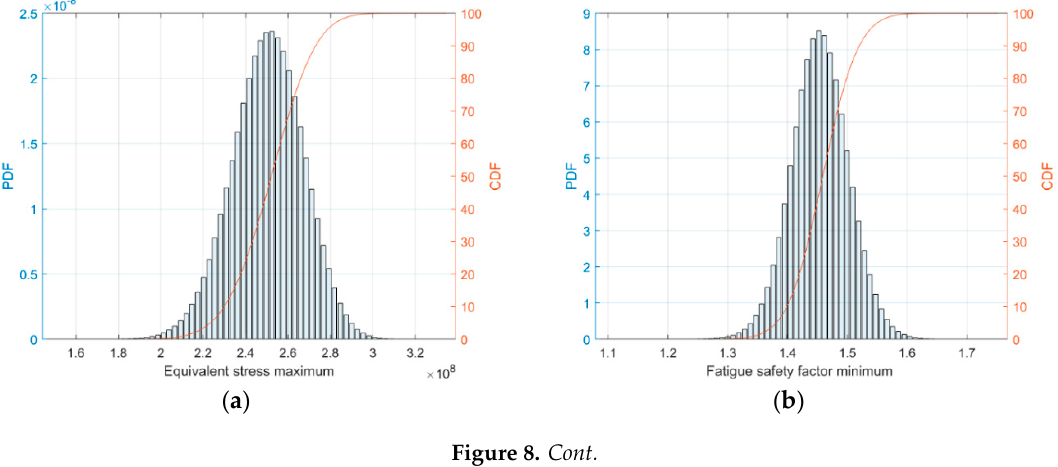
Table 9. Characteristics of design